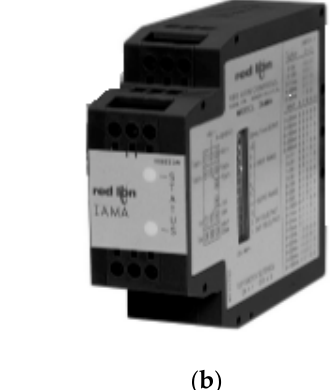
Figure 4. ( a ) Sensor to measure I A : sensor ACS714. ( b ) Sensor to measure V A : sensor IAMA3535.